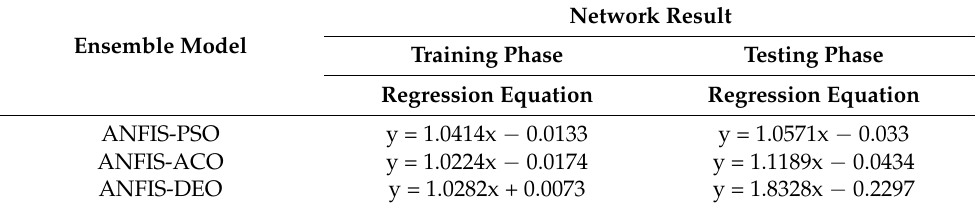
Figure 14. Scatter plot of the SP demand prediction for ANFIS-DEO: ( a ) Testing phase, ( b ) training phase. Table 10. The calculated regression equation of the implemented models.